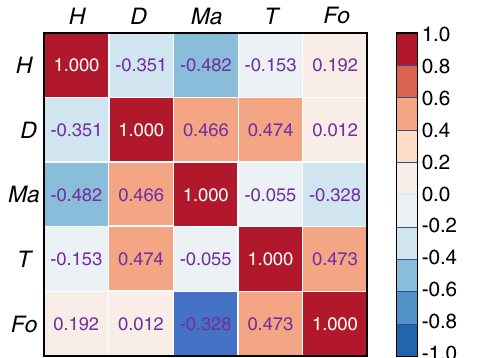
Fig. 8 The Pearson matrix. The matrix is used to show the correlation among the fi ve mechanistic variables.